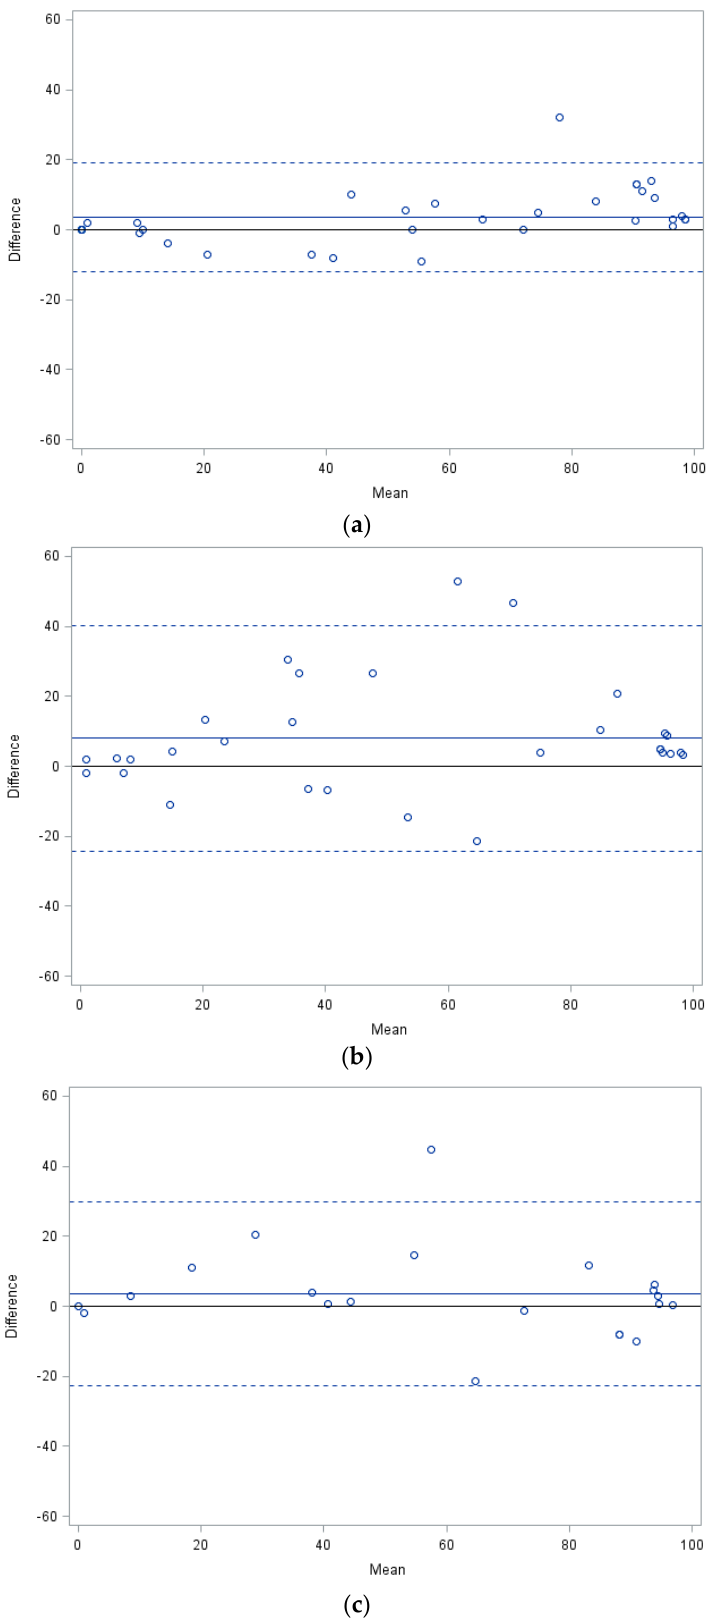
Figure 1. Cont. Figure 1.